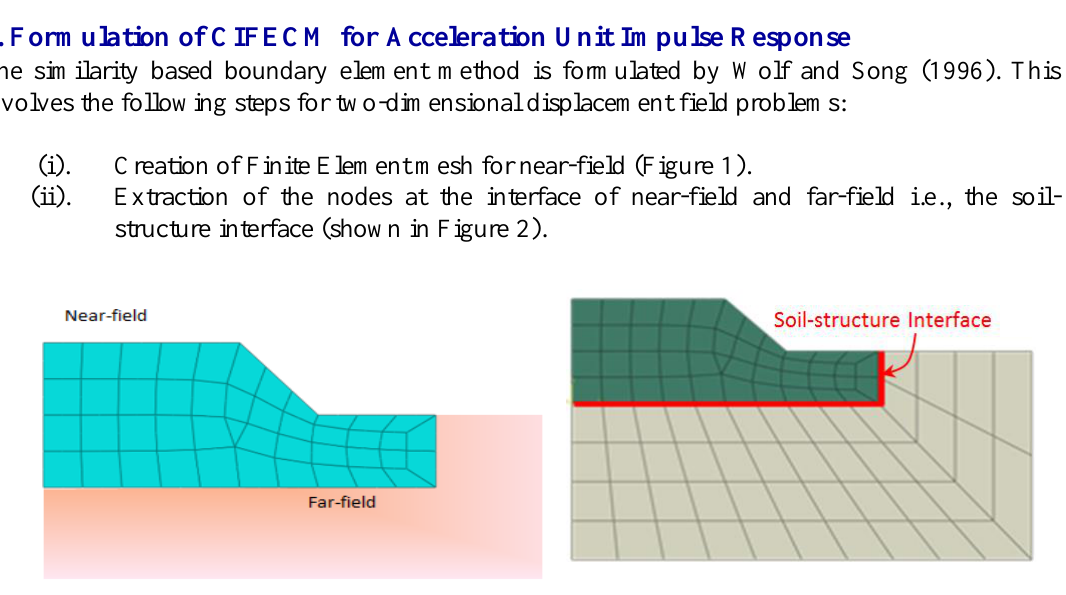
Figure 1. Near- and far-fields of SSI system. Figure 2. Soil-structure